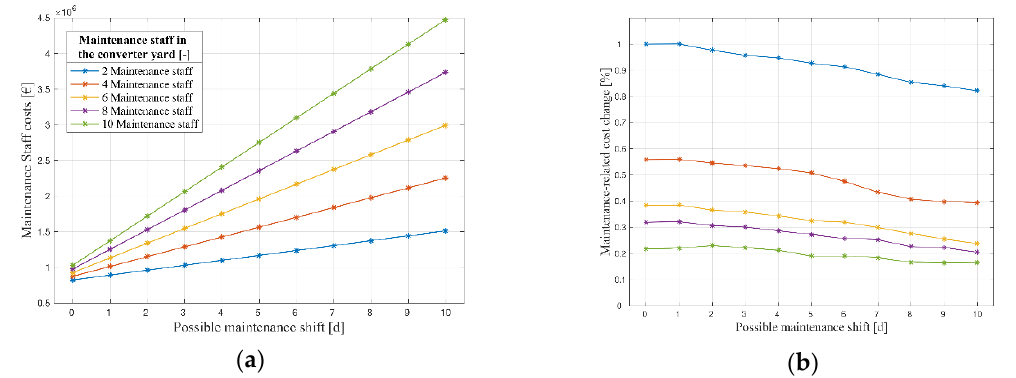
Figure 13. Maintenance staff costs ( a ) and maintenance-related costs change ( b ) for the total operation time of the HVDC system over possible maintenance shift for different number of maintenance staff in the converter-yard.